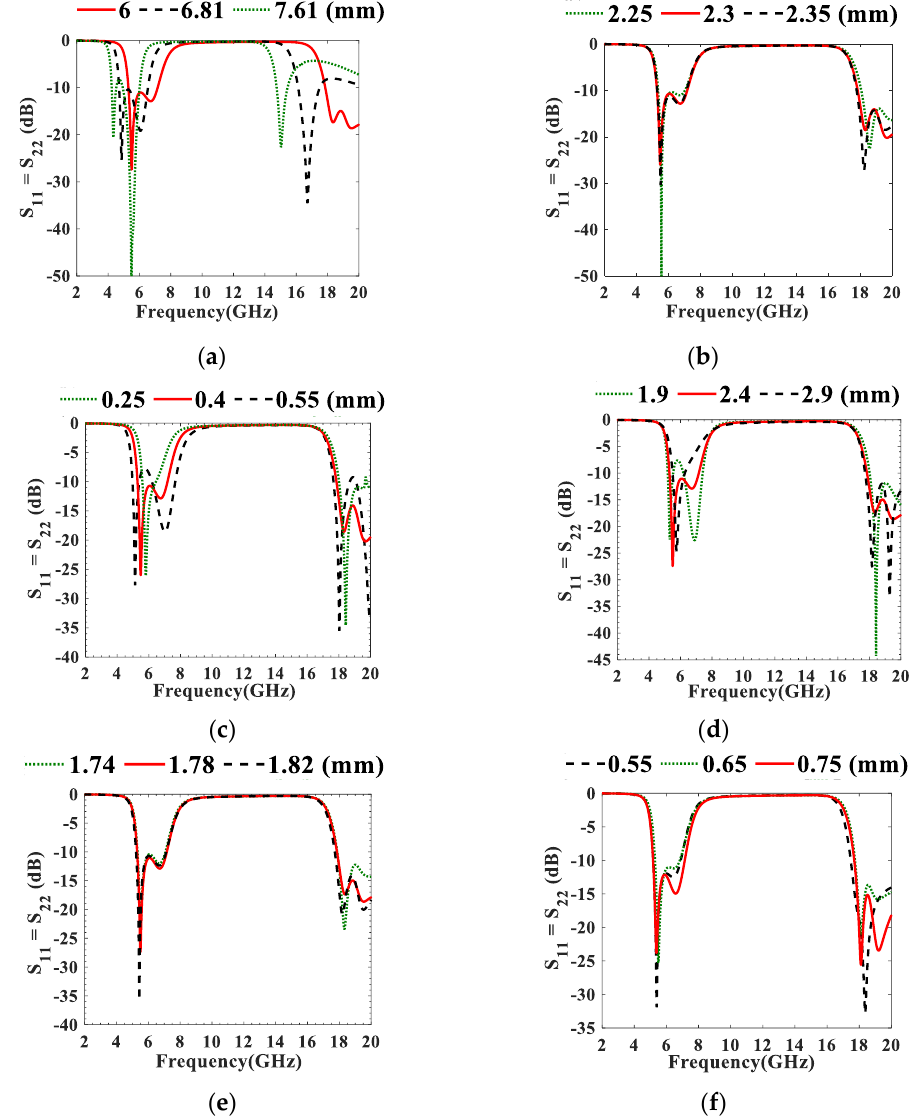
Figure 6. Parametric studies of the proposed 6.55 GHz UTL IBF on ( a ) L res2 , ( b ) W res , ( c ) S , ( d ) L t , ( e ) W p and ( f ) rVia.